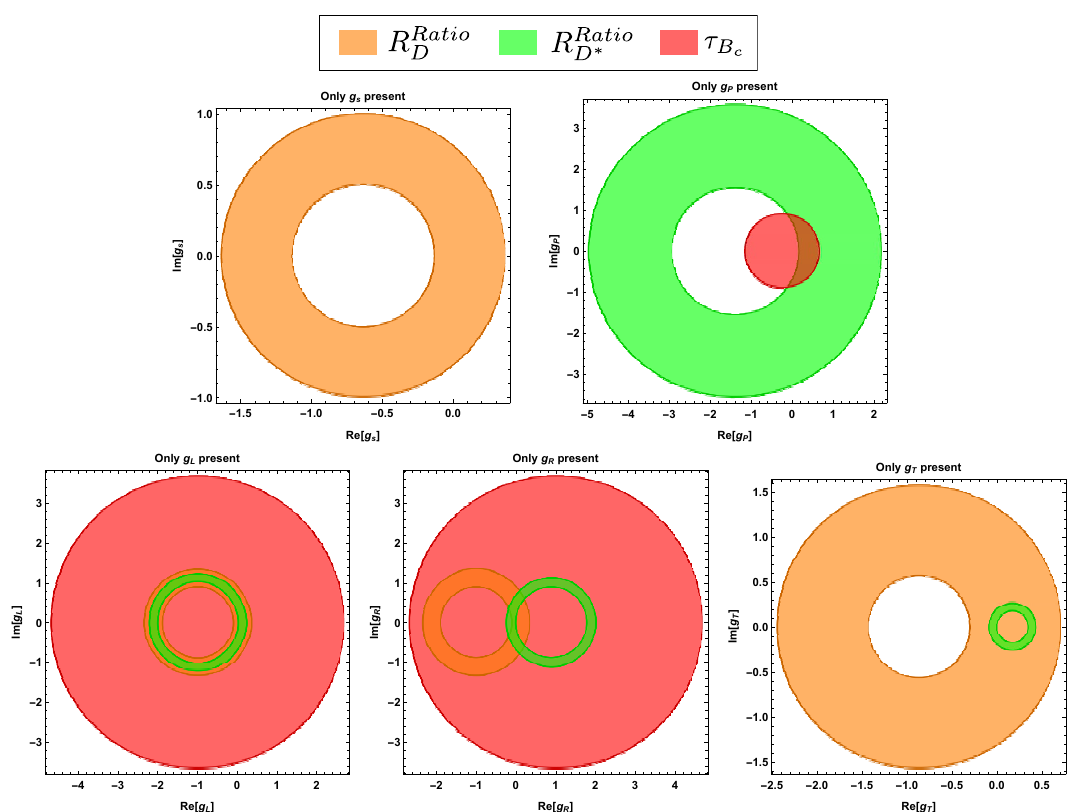
Figure 3 . Constraints on the individual new-physics couplings from the measurements of R Ratio . We require that the couplings reproduce the measurements of R Ratio R Ratio , and τ B D ∗ c